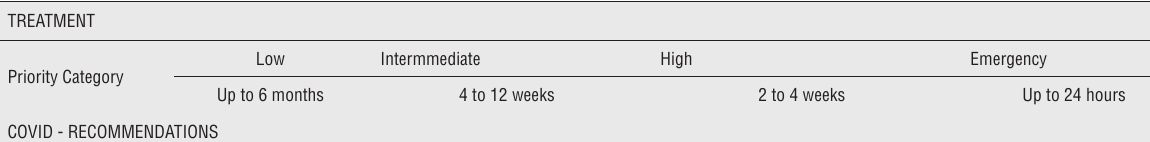
Table 2. Indications and Prioritization of lithiasis surgery during COVID-19